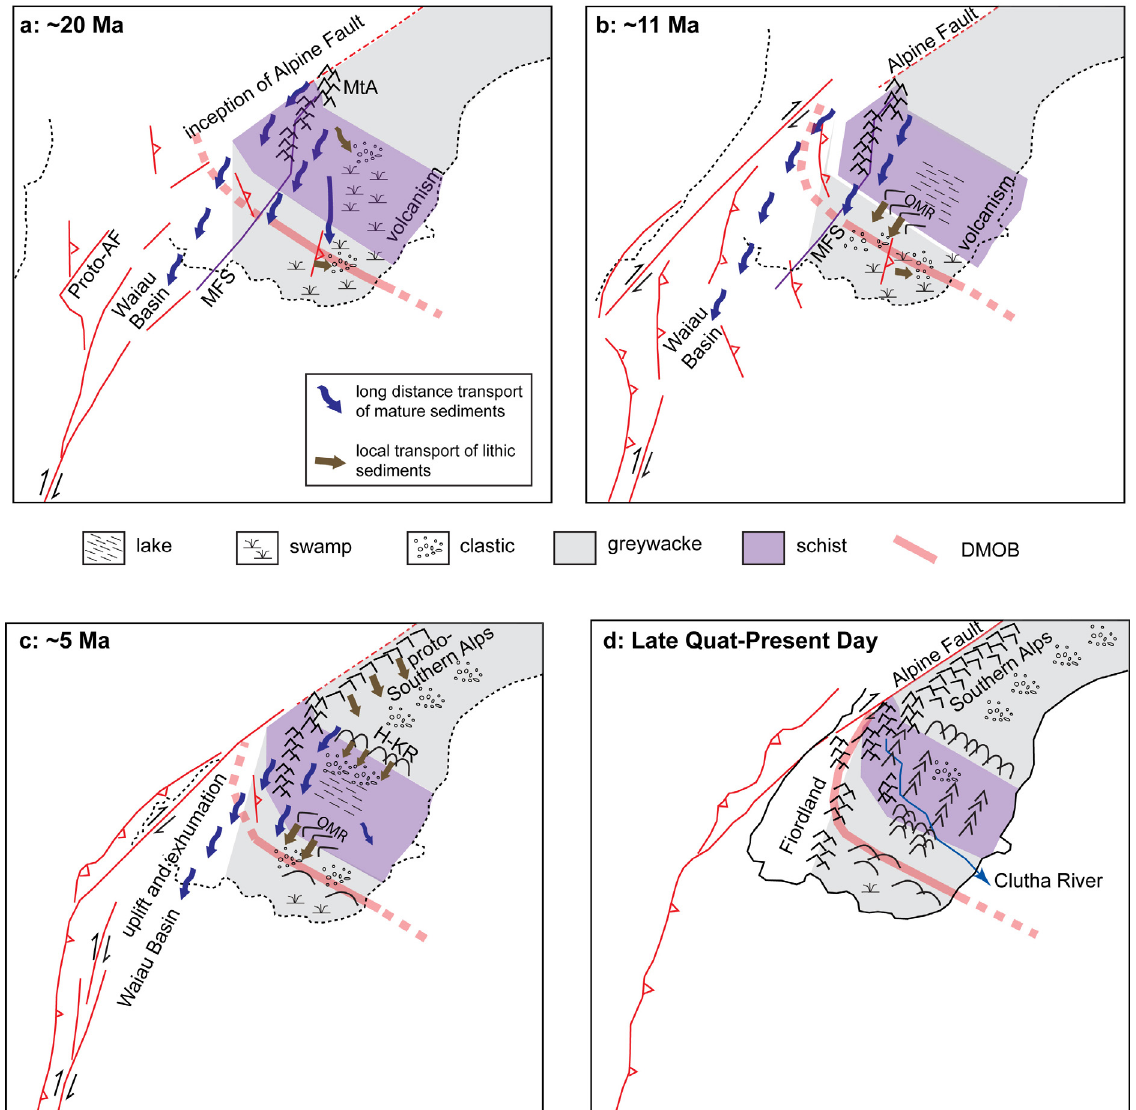
Figure 4. Series of plate reconstructions for Southern New Zealand based on Sutherland et al. [37], Sutherland [38], and King et al. [8]. ( a ) Reconstruction for ~20 Ma with the present day coastline shown as a dashed line. To the south of New Zealand plate motion was being taken up along active transform faults with a likely step-over to the west onto the proto-Alpine Fault. Otago and Southland were low lying with coal measures being formed. The Moonlight Fault System (MFS) was active at this time; ( b ) Reconstruction for ~11 Ma. Lake Manuherikia extended across much of Otago, Southland was still subsiding slowly with coal measures forming and local uplift on pre-existing structures produced lithic sedimentation in places. The Old Man Range (OMR) bounds the lake to the south; ( c ) Reconstruction for ~5 Ma. Uplift of the Hawkdun-Kakanui Ranges (H-KR) produces lithic sediments that start to fill Lake Manuherikia from the north. The proto-Clutha river drains east Otago; ( d ) Late Quaternary and present day. Uplift has developed across the whole of the Otago region with a series of NE-trending ranges. The Clutha River now drains nearly all of Otago cutting through NE-trending ranges [39]. DMOB: Dun Mountain Ophiolite Belt